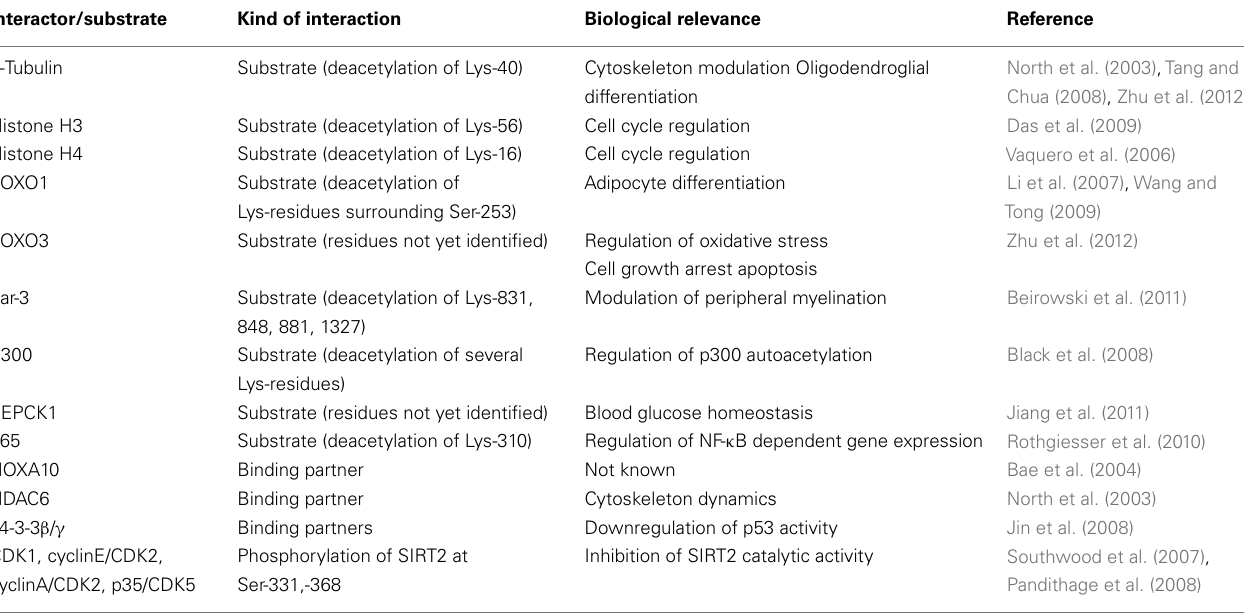
Table 1 | SIRT2 substrates and interactors and their biological